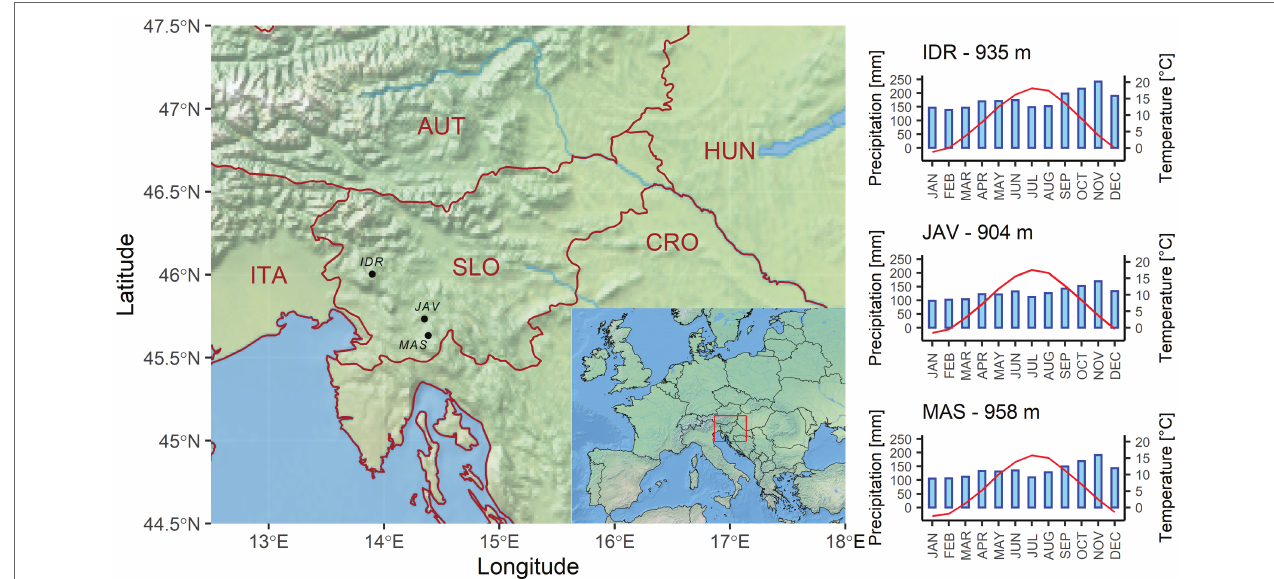
FIGURE 1 | Geographical locations and climate diagrams of selected sites, i.e., Idrija (IDR), Javornik (JAV), and Ma š un (MAS). Climate diagrams are based on E-OBS daily climate datasets for the period from 1960 to 2016.